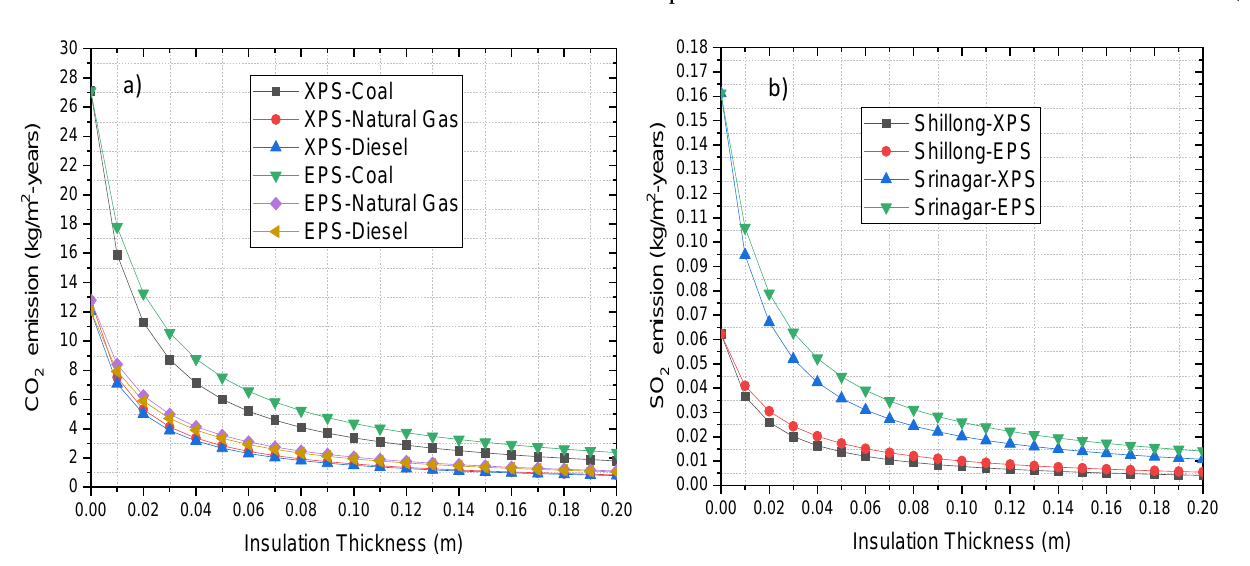
Figure 4. Fuel gas emission–insulation thickness: ( a ) CO 2 (Shillong) ( b ) SO 2 -Coal (Shillong and Srinagar).